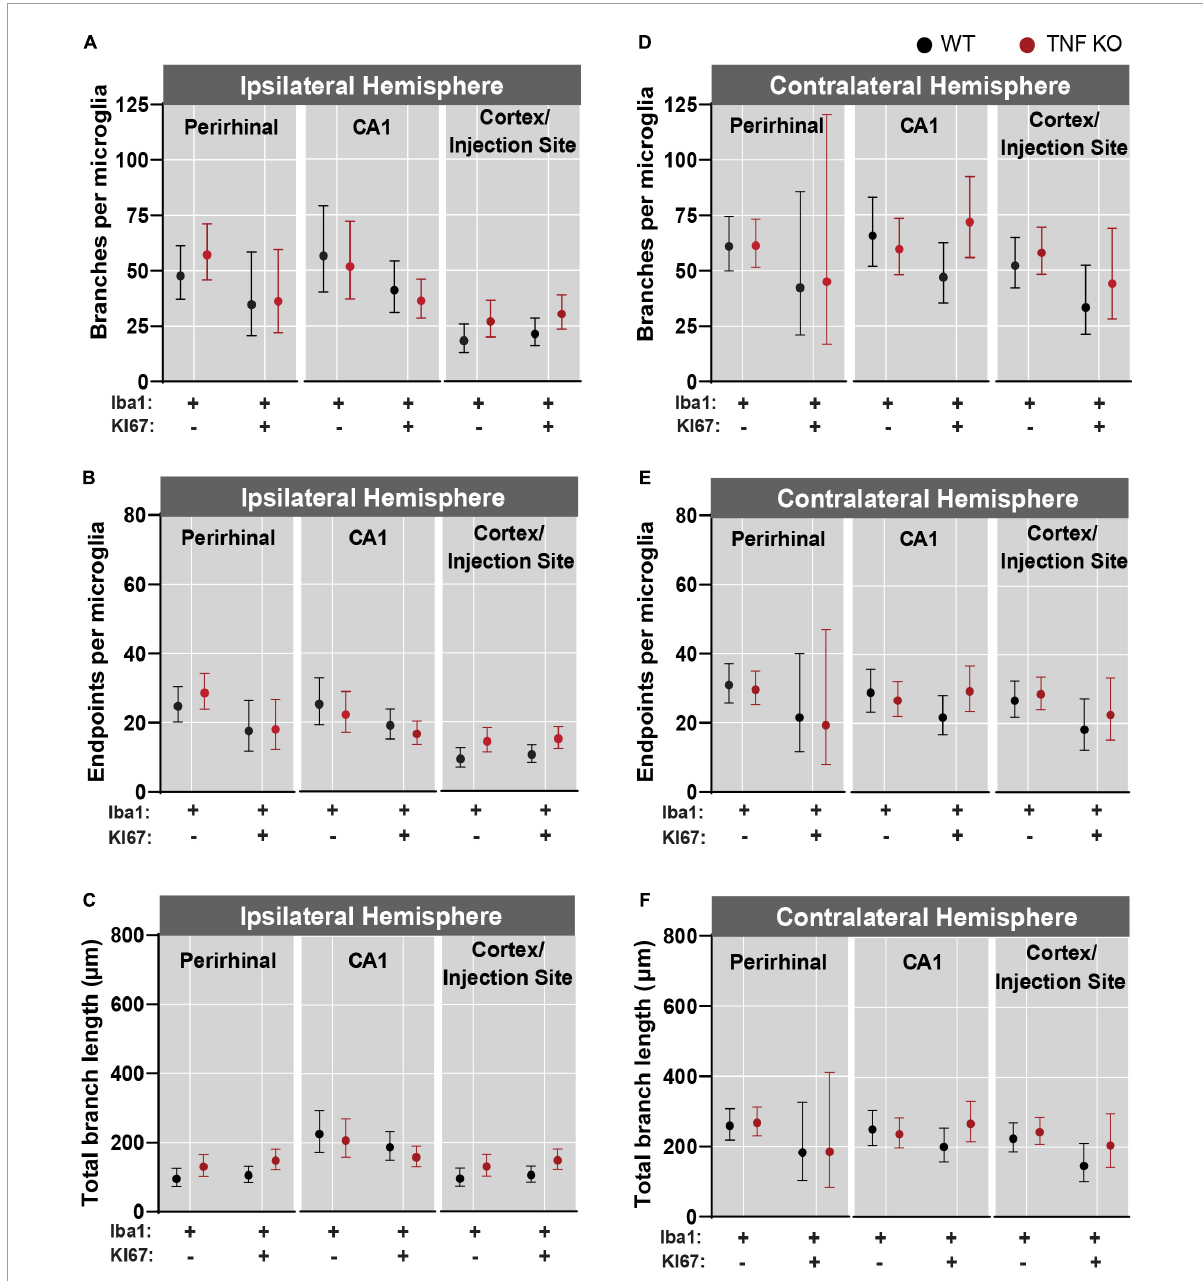
FIGURE5 Microglial activation was greatest near the kainic acid injection site. Microglia were isolated from the perirhinal cortex, CA1, and cortex/injection site and data were analyzed across regions from both the ipsilateral and contralateral hemispheres. (A) Branches, (B) endpoints, and (C) total branch length per individual microglia isolated from the ipsilateral hemisphere. (D) Branches, (E) endpoints, and (F) total branch length per individual microglia isolated from the contralateral hemisphere. All data were analyzed using linear mixed models and results are presented as point estimates with 95% confidence intervals (see Supplementary Tables 1–3 ). TNF- α KO KI67 − n = 181 microglia; WT KI67 − n = 139 microglia; TNF- α KO KI67 + n = 87 microglia; WT KI67 + n = 71